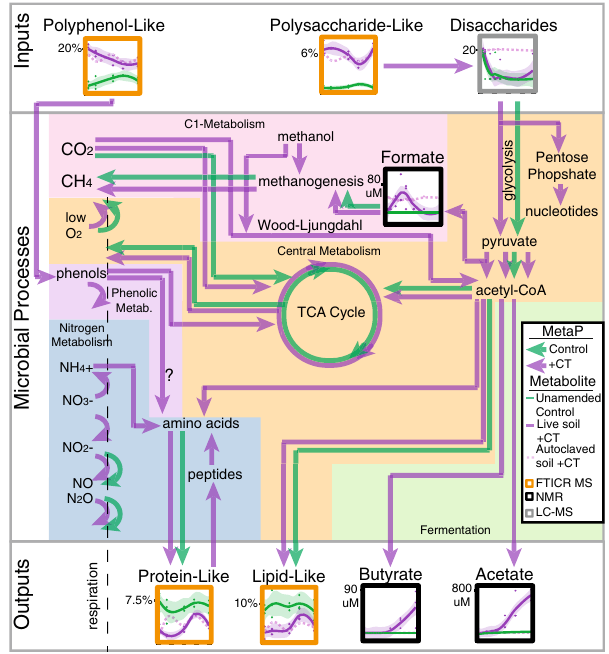
Fig. 7 Coupled metaproteome and metabolite data indicated polyphenol amendment did not inhibit soil microbial metabolism. Arrows indicate metaproteome gene expression data, with green representing unamended and purple indicating CT-amended pathways. Metabolite dynamics are shown in boxed graphs, with lines indicating average signal for live CT ( n = 3 individual biological replicates, solid purple), and unamended control ( n = 3 individual biological replicates, green) microcosms with shaded areas including the 95% con fi dence interval and individual data points plotted, and autoclaved CT soil (dotted light purple). The methodology used to detect the metabolite is highlighted by box color (noted in the graphical legend), with FTICR-MS (orange) data given as percent of identi fi ed peaks, NMR (black) as umol, and LC – MS (gray) as log2(peak areas). Nitrogen metabolism (blue box) is discussed in Supplementary Note